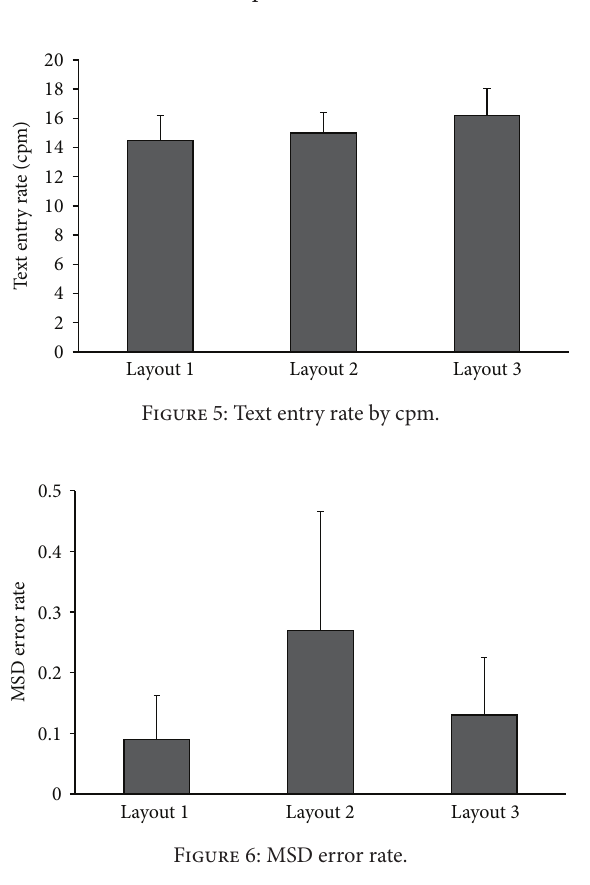
Figure 8: Subjective